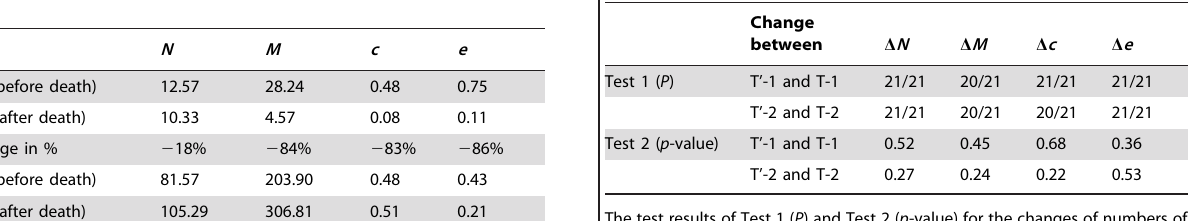
Table 1. Parameter changes of the former collaborators’ networks after superstars’ deaths.